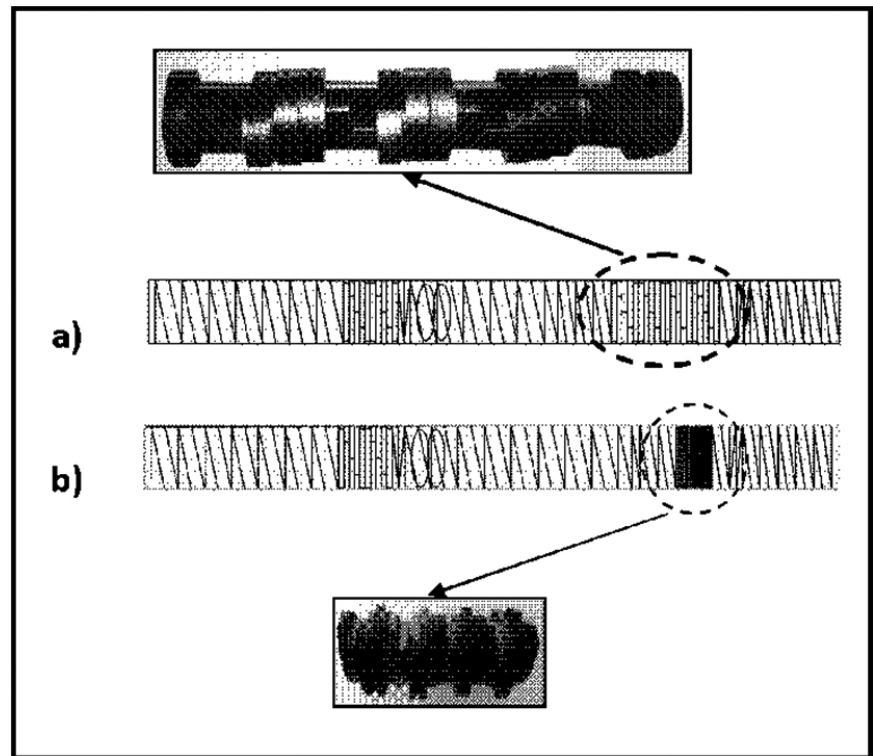
Figure 1. Profile of the twin extrusion screws used for the PBT/ABS blends preparation, where (a) screw type 4KB45/5/42 and (b) screw type